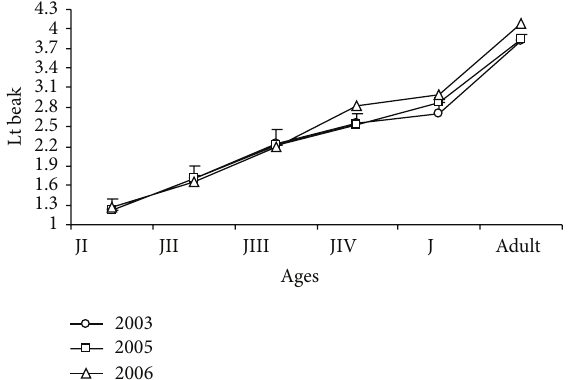
Figure 10: Mean length of the beak (cm) of Sterna hirundinacea chicks.